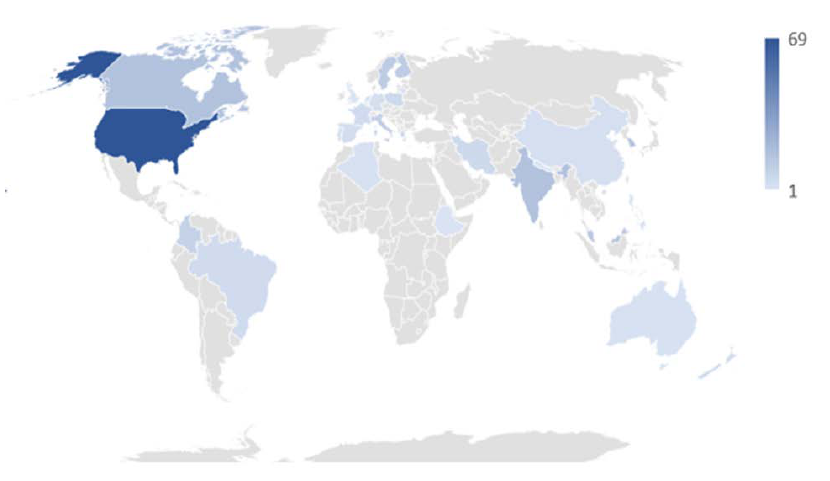
Figure 7. Studies on MSD in agriculture by country (1995–2020).